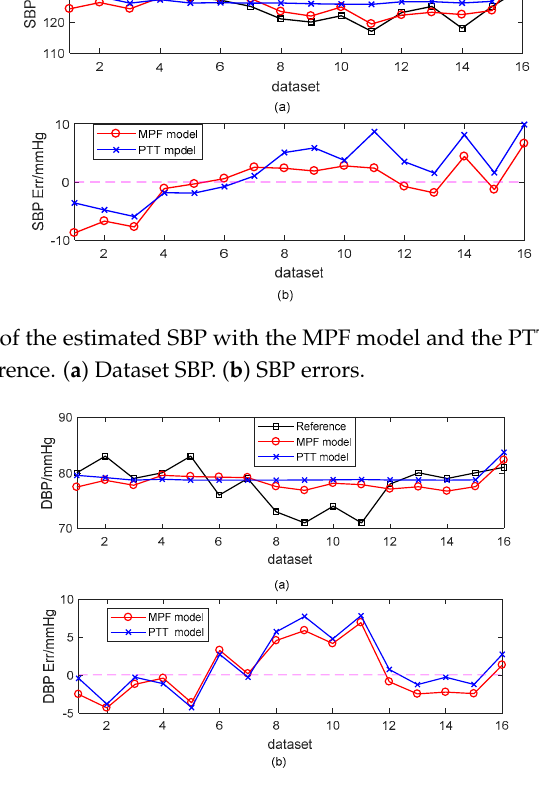
Figure 9. An example of the estimated DBP with the MPF model and the PTT-based model with the cuff-based BP as a reference. ( a ) Dataset DBP. ( b ) DBP errors.